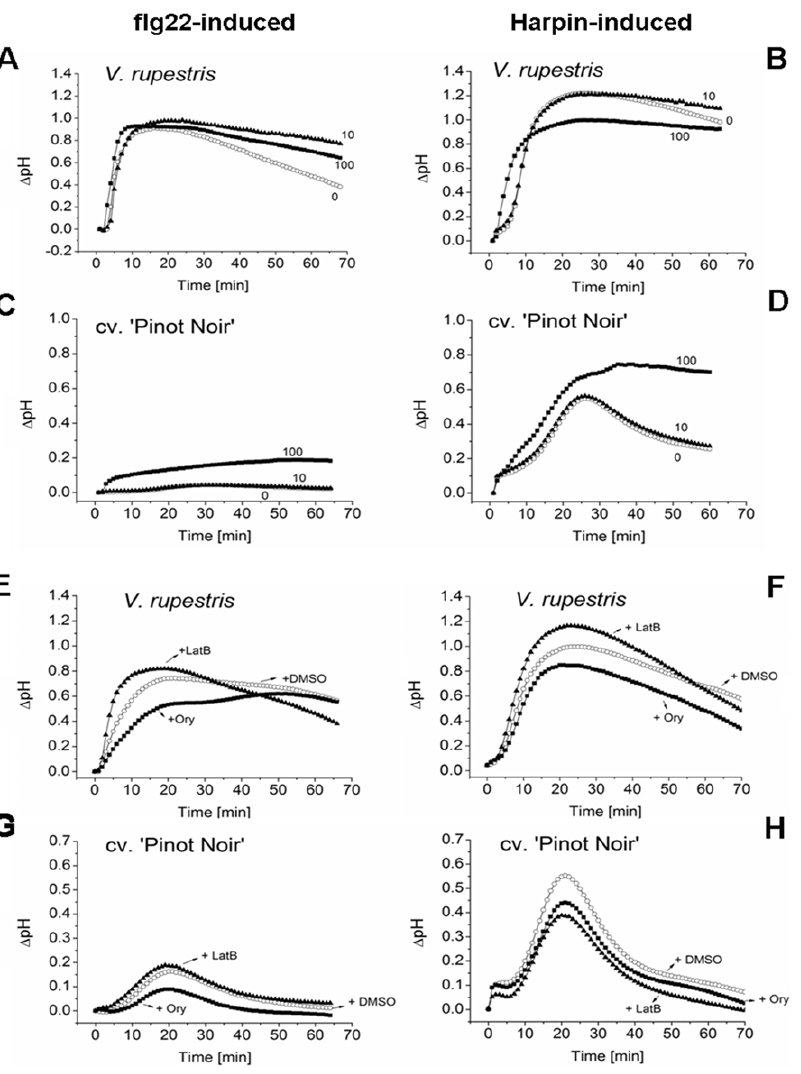
Figure 2. Feedback of downstream factors on flg22- and Harpin-induced apoplastic alkalinisation. A–D Effect of the MAPK cascades inhibitor PD98059 (PD) on flg22- and Harpin-dependent alkalinisation in V. rupestris ( A, B ) versus V. vinifera cv. ‘Pinot Noir’ ( C, D ). Cells were elicited by either 1 m M flg22 ( A, C ) or 9 m g . ml 2 1 Harpin ( B, D ) in combination with 0 m M (open circles), 10 m M (closed triangles), or 100 m M (closed squares) PD98059 (PD). E–H Effects of cytoskeletal drugs on flg22 and Harpin-dependent alkalinisation, respectively. Effects of the microtubule inhibitor Oryzalin ( + Ory, 20 m M, closed squares), or the actin inhibitor Latrunculin B ( + LatB, 2 m M, closed triangles) in V. rupestris ( E, F ) versus V. vinifera cv. ‘Pinot Noir’ ( G, H ) were compared to the solvent control (DMSO, open circles). Representative timelines from five independent series are shown.